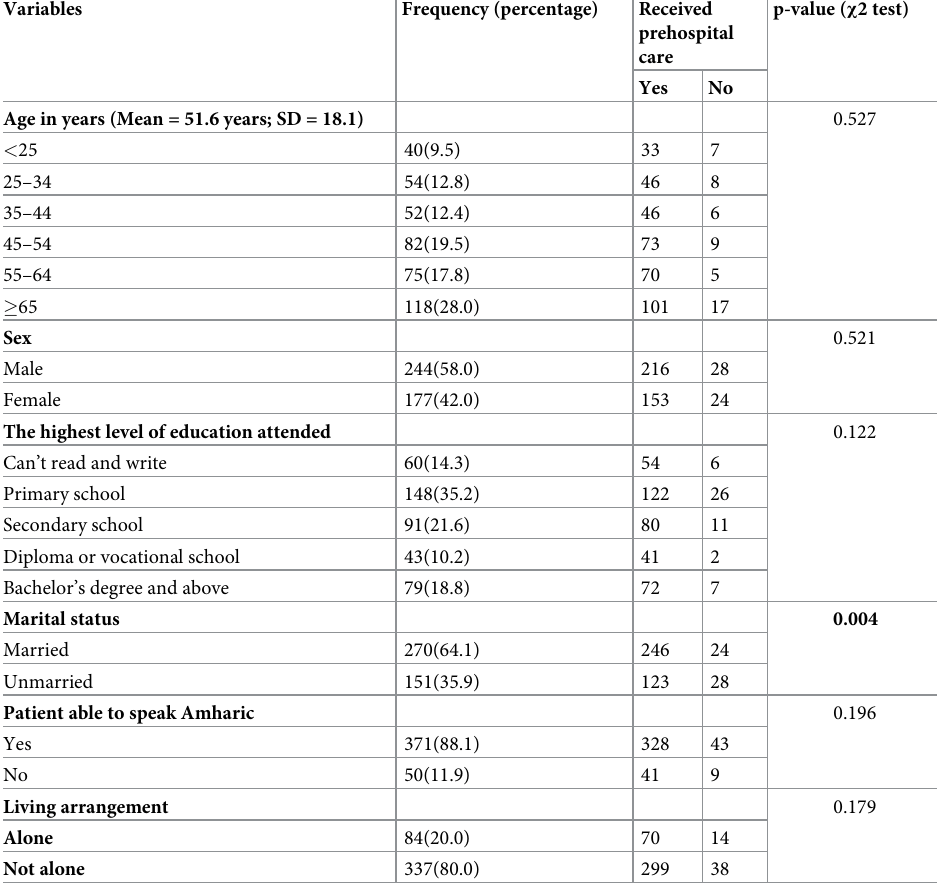
Table 1. Description of socio-demographic (predisposing) characteristics by prehospital care utilization among severe and critical COVID-19 patients, Addis Ababa, Ethiopia, May to July 2021.